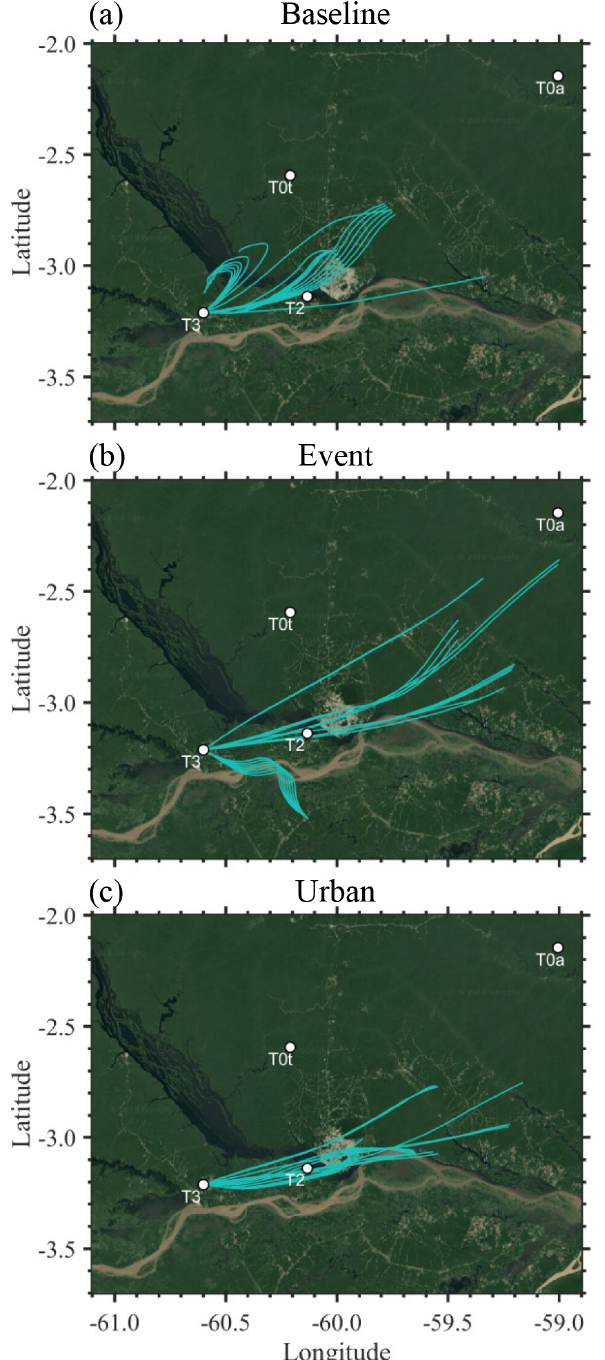
Figure 9. Air-mass back-trajectories associated with the three clus- ters of the FCM analysis. Trajectories were calculated using HYS- PLIT4 in steps of 12min and are shown for 10h (Draxler and Hess, 1998). A total of 20 trajectories are plotted for each cluster, cor- responding to the times of highest degree of membership to that cluster.